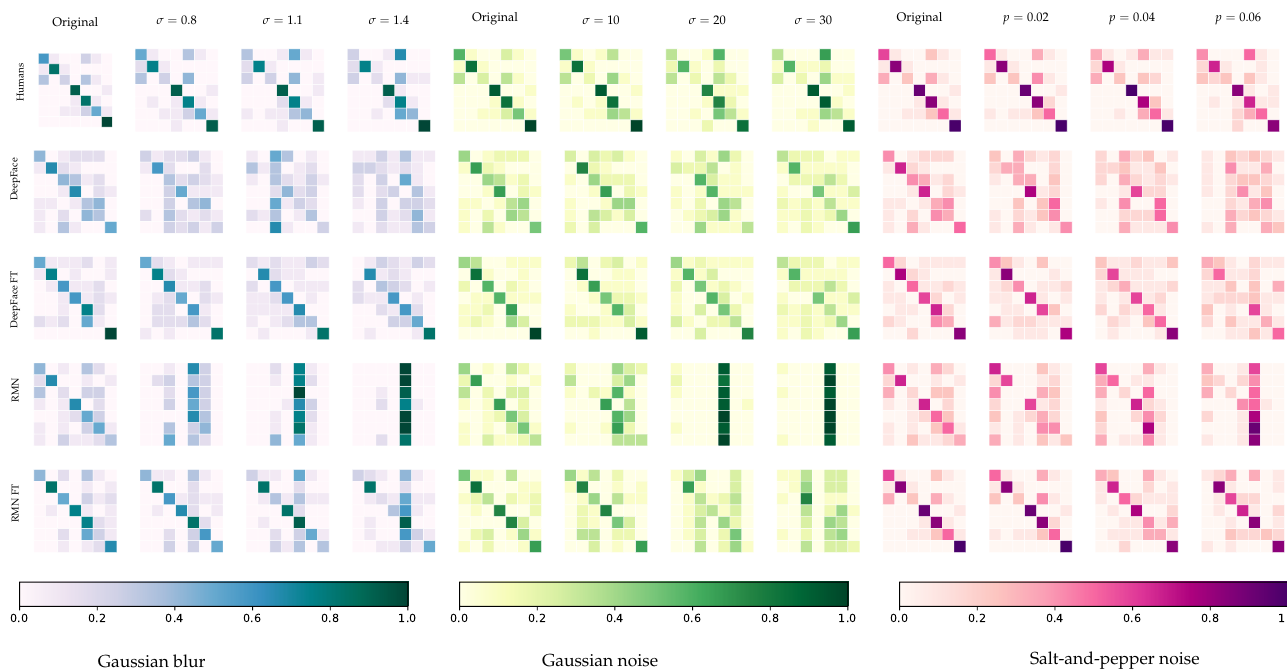
Figure 3. Illustration of the confusion matrices generated for humans, pre-trained (i.e., DeepFace and RMN) and fine-tuned (FT) models, for each distortion type (i.e., GB, GN, and SP) and level. Lines correspond to ground truth labels, while columns represent predicted labels. Emotions are presented in alphabetical order, i.e., anger, disgust, fear, happiness, neutral, sadness, and